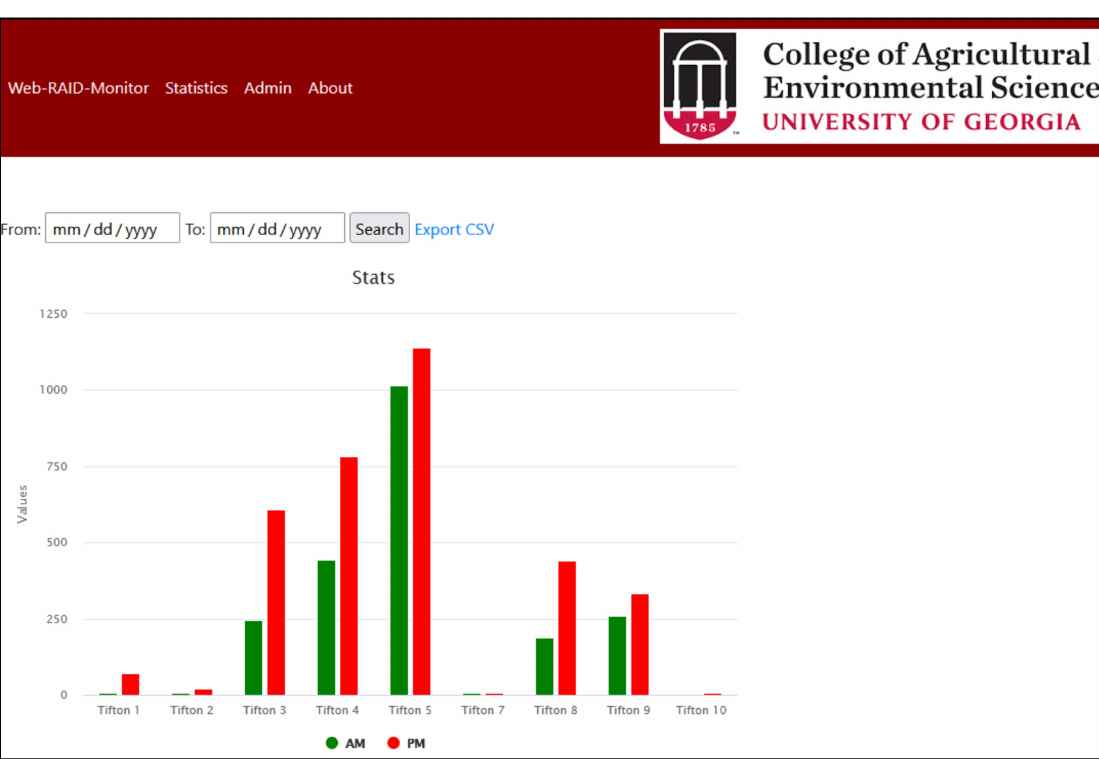
Figure 10. Bar chart of whitefly counts at each station for AM and